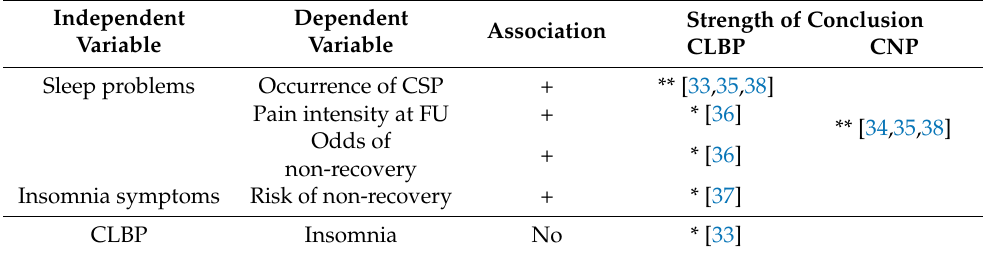
Table 10. Brief overview of the main results of the longitudinal